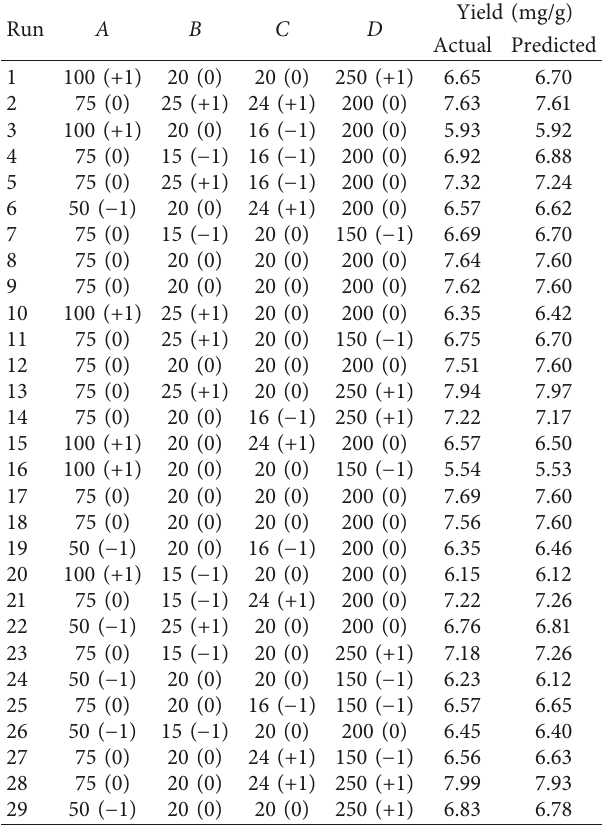
Table 1: Box–Behnken design matrix and the actual and predicted values for the yields of C. camphora